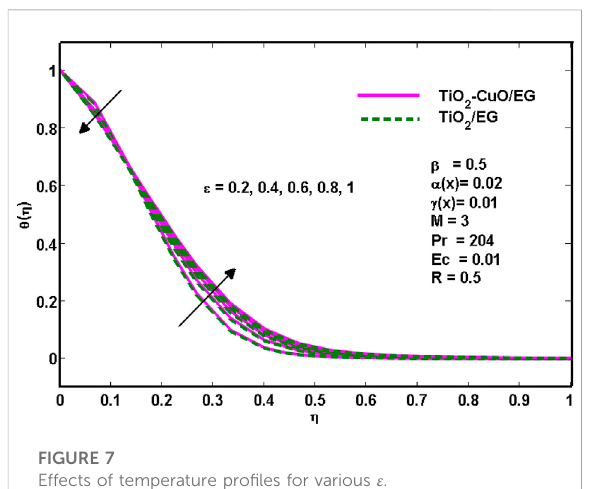
FIGURE 7 Effects of temperature pro fi les for various ε .